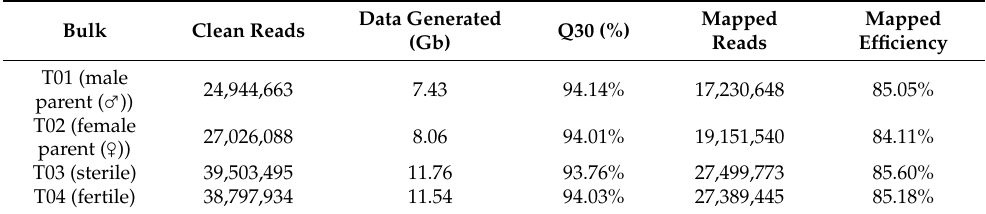
Table 3. Summary of sequencing data of BSR-seq.